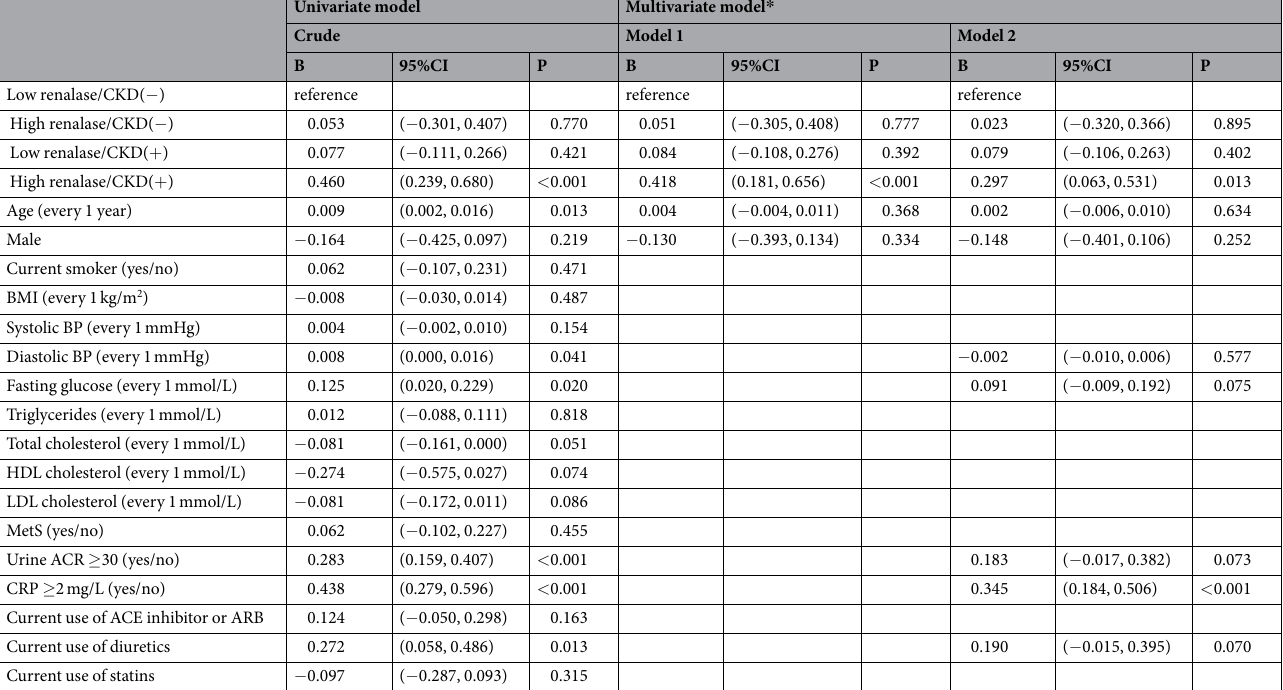
Table 4. Effects of risk factors on serum endothelin-1 levels. B = linear regression coefficient, which represents the mean change in serum endothelin-1 levels for per unit increase in the levels of the associated risk factor (for continuous variables) or compared to the reference group (for categorical variables). ACE = angiotensin- converting enzyme, ARB = angiotensin II receptor blocker, BMI = body mass index, CI = confidence interval, CKD = chronic kidney disease, HDL = high-density lipoprotein, LDL = low-density lipoprotein, MetS = metabolic syndrome. * Multivariate linear regression